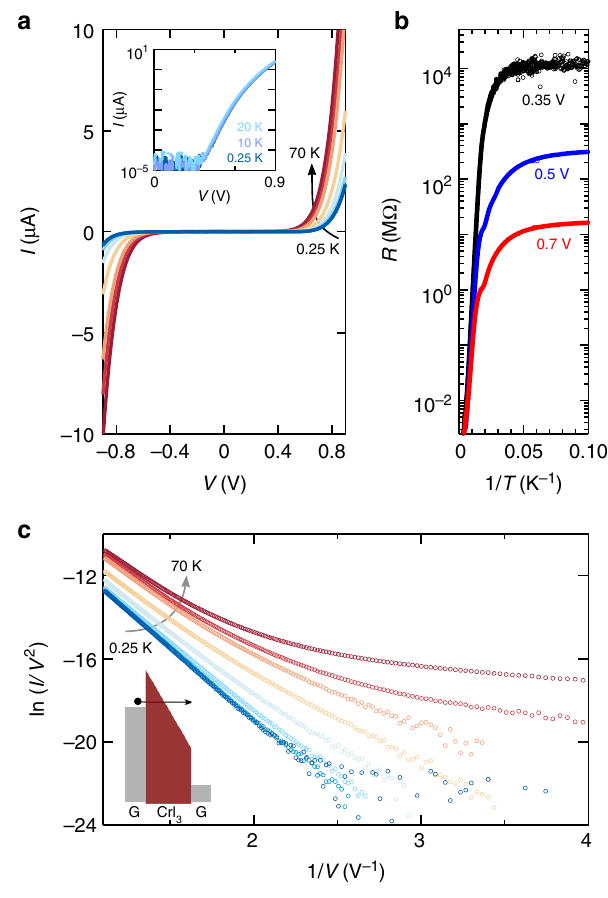
Fig. 2 Electron tunneling in few-layer CrI 3 vertical junctions. a Current measured on the device shown in Fig. 1d as a function of bias applied between the graphene contacts for T ranging from 0.25 to 70 K (the intermediate temperatures are 10, 20, 30, 40, 50, and 60 K). Below T = 20 K, the I – V curves become temperature independent as shown in the inset, indicating that transport is determined by tunneling (the overlapping area of the graphene contacts is 4 µ m 2 and the thickness of the CrI 3 layer is ~7 nm). b Arrhenius plot of the resistance measured at different bias voltages (0.35, 0.5, and 0.7 V). c In the tunneling regime (i.e., for T < 20 K), ln( I / V 2 ) is linearly proportional to 1/ V , as expected for Fowler-Nordheim tunneling (charge carriers tunnel into the conduction band through band- gap of CrI 3 that is tilted by the applied bias forming a triangular barrier, as illustrated schematically in the inset). The different curves correspond to measurements performed at the same temperatures as in Tunneling transport in vertical junctions . We investigated vertical transport from room temperature down to T = 0.25 K, by measuring the I – V curves of devices such as the one in Fig. 1d.